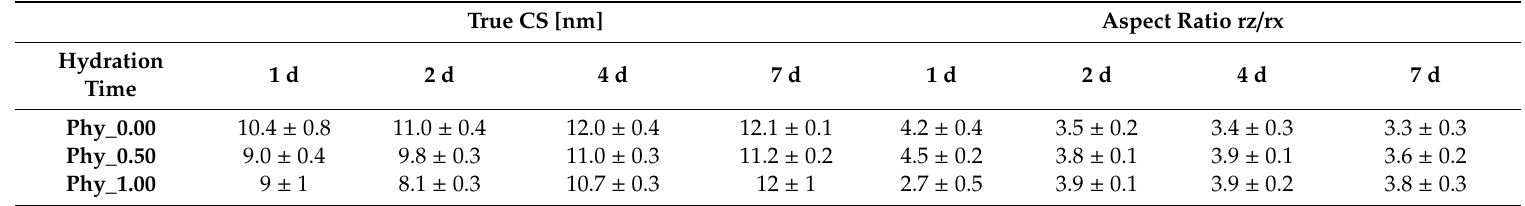
Table 6. True CS and aspect ratio rz / rx of CDHA crystallites in the storage samples after 1 d, 2 d, 4 d and 7 d of hydration; a 0.2 M Na 2 HPO 4 solution was used as the mixing liquid with an L / P of 0.3 ml / g Powder ; the samples were stored at 37 ◦